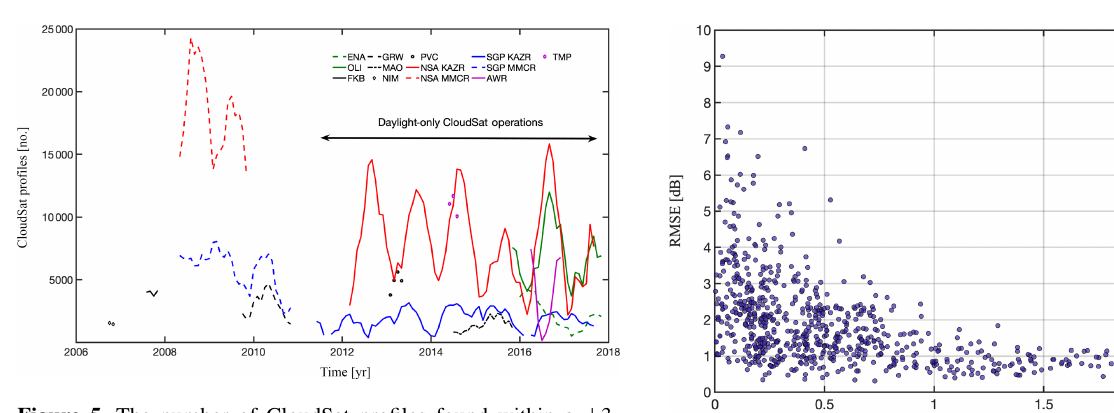
Figure 5. The number of CloudSat profiles found within a ± 3- month window suitable for calibrating the ARM cloud radars as a function of time for the different ARM sites. Figure 6. The relationship between the minimum RMSE (dB) achieved in a particular ARM–CloudSat comparison and the cor- responding number of CloudSat